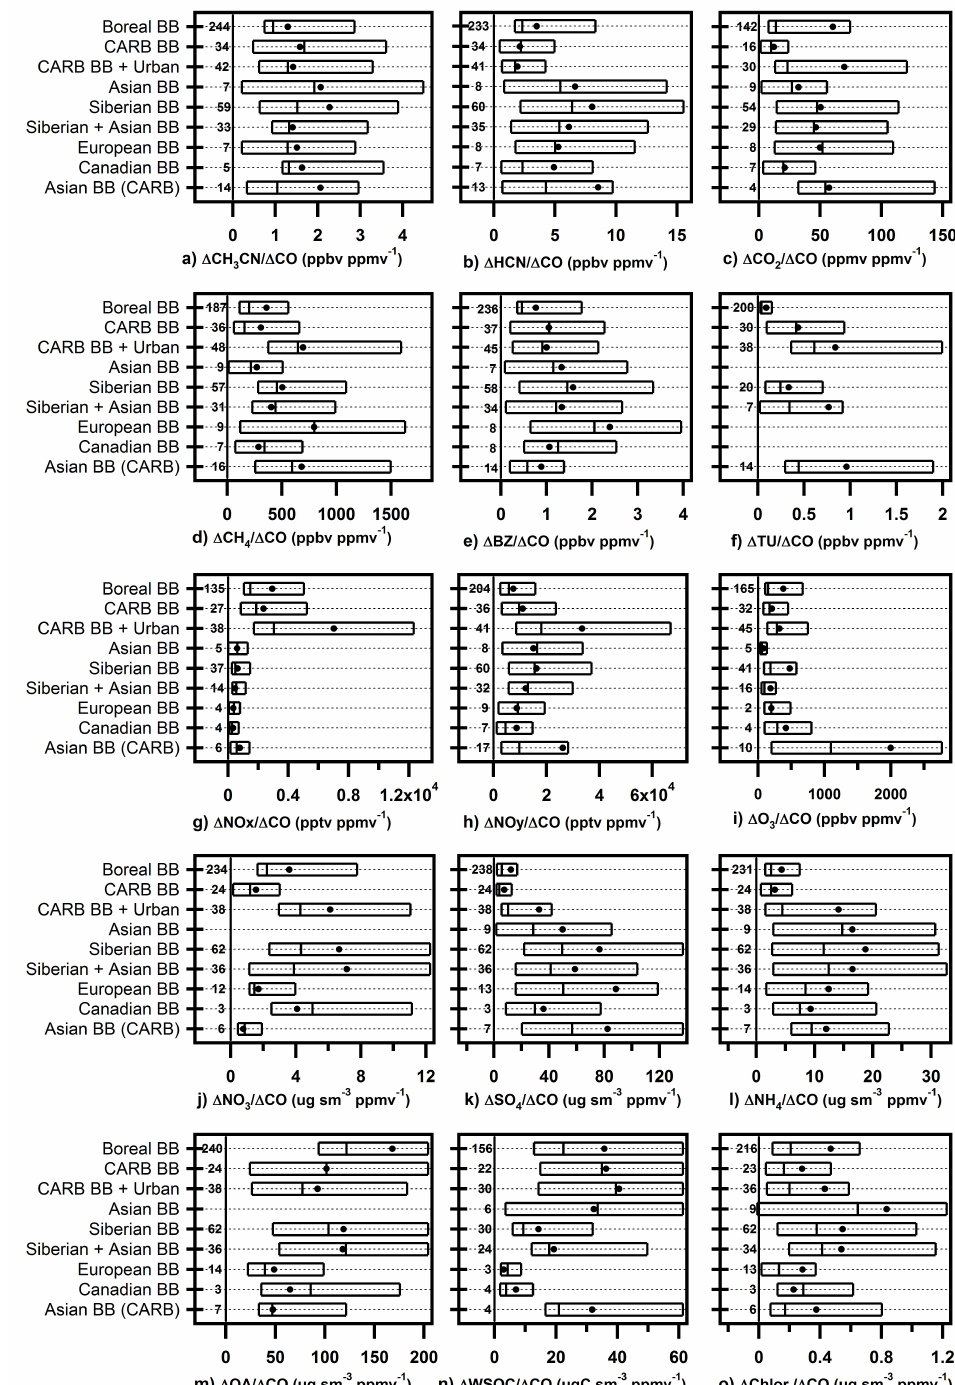
Fig. 3. Comparison of 25th and 75th percentile, mean and median NEMR values for various trace gas and aerosol components in all biomass burning plumes intercepted by the NASA DC-8 aircraft during ARCTAS-A, ARCTAS-B and ARCTAS-CARB. Numbers inside the graphs represent the number of plumes present in each category, the black dots and vertical lines in the middle are median and mean, respectively; the long black line indicates the location of zero NEMR for each compound and the sides of the rectangles are the 25th and 75th percentile